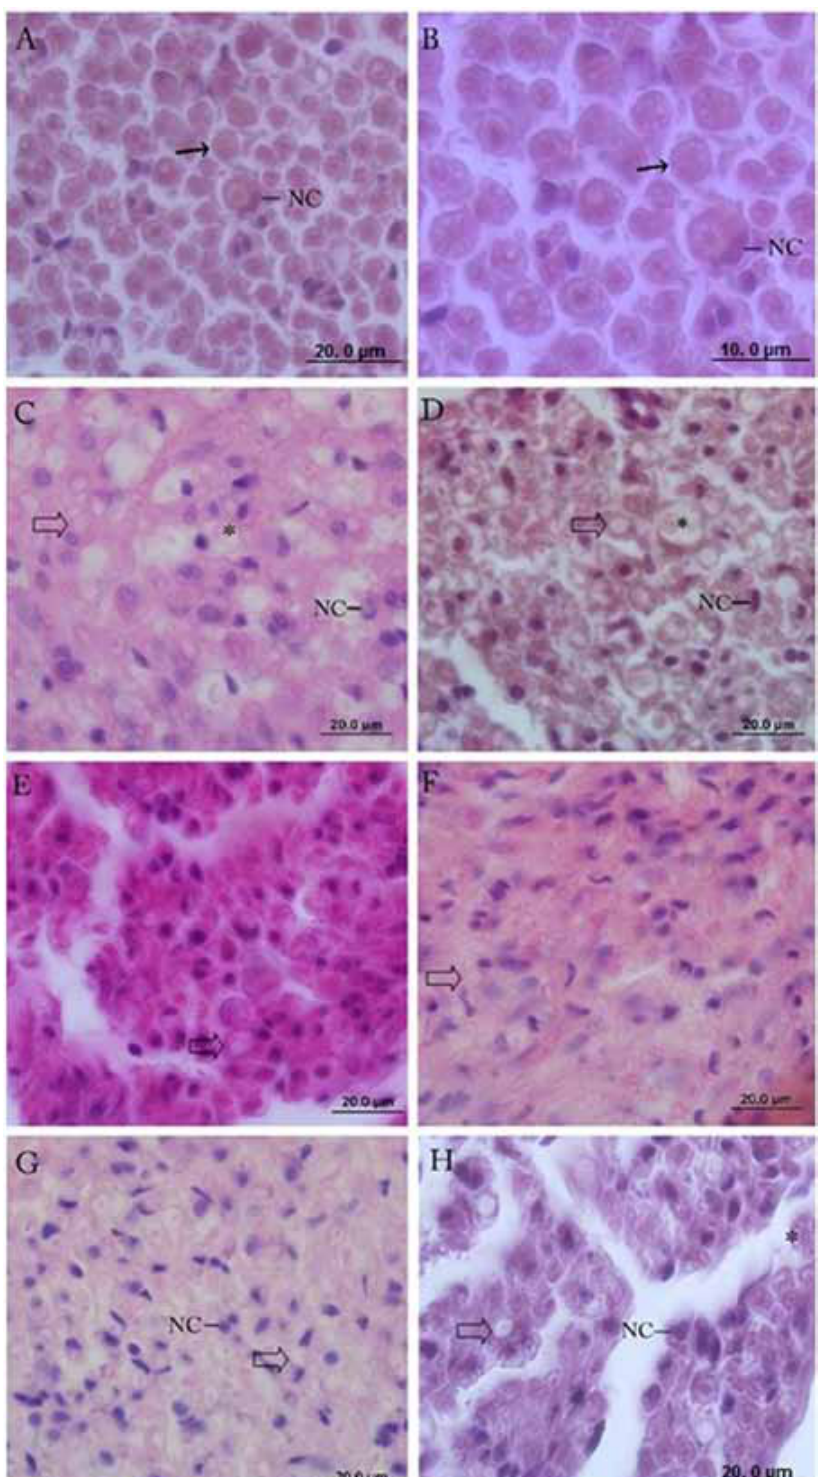
Figure 1: Photomicrographs of median nerves of Wistar rats, cross section, Hematoxylin and Eosin staining. In A, Control group and B in greater increase, with intact peripheral nerve fibers (arrow) and cellular nuclei (NC). C, Injury group, with presence of empty spaces delimited by endo - neurium (leaked arrow) and hypercellularity (NC). In D, Injury + Fibrin group, showing the same characteristics of empty spaces (arrow cast) and increase of cellular nuclei (NC) and some fibers in regeneration in the periphery (*). E, treadmill group, with presence of voids (arrow cast), also evidenced in the group Swimming (F). In G, treadmill + Fibrin group also denoting the previous aspects, with high number of cellular nuclei (NC). H, group Swimming + Fibrin, but with its peripheral fibers having larger diameter and quantity of regenerated fibers